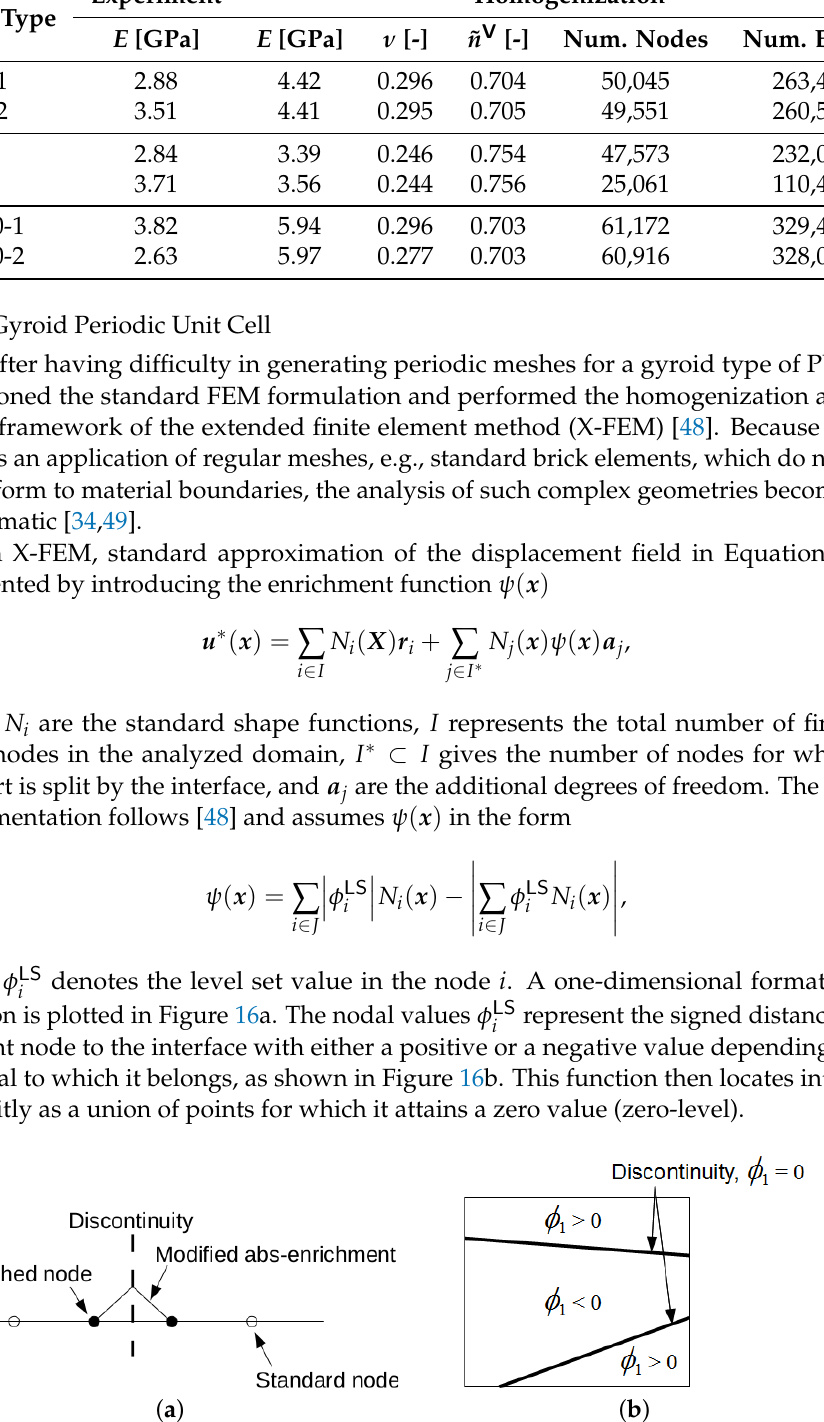
Figure 16. ( a ) Modified abs-enrichment for 1D problem, ( b ) element crossed by two interfaces of the same material